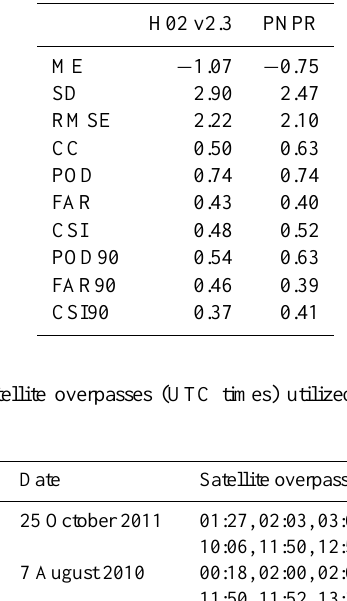
Table 3. Cumulative error statistics of H02 v2.3 and PNPR re- trievals for all available satellite overpasses for all case studies.